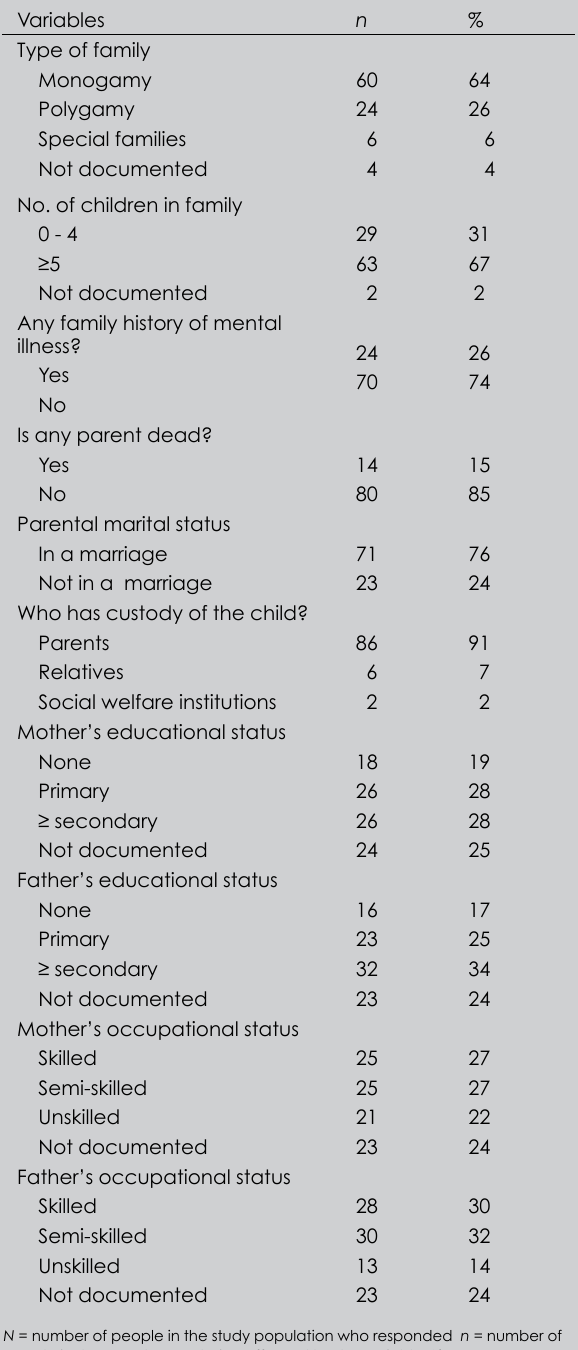
Table I. Socio-demographic characteristics of the children and adolescents ( N =94) Variables n